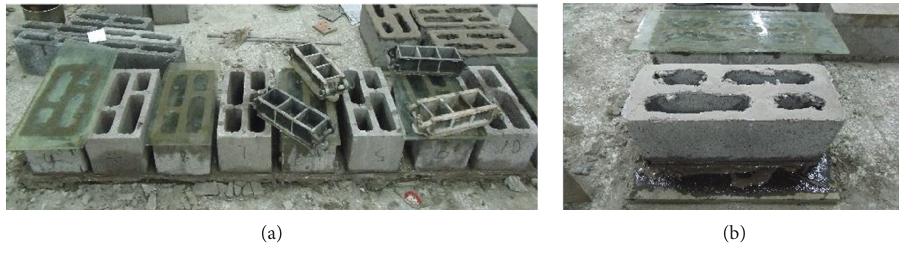
Figure 5: Leveling of the